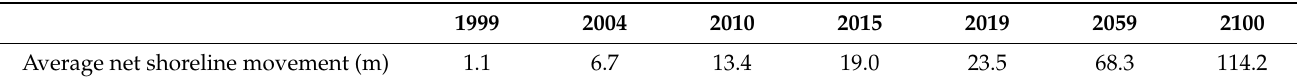
Table 8. Evolution of the Mazatlan coastline.